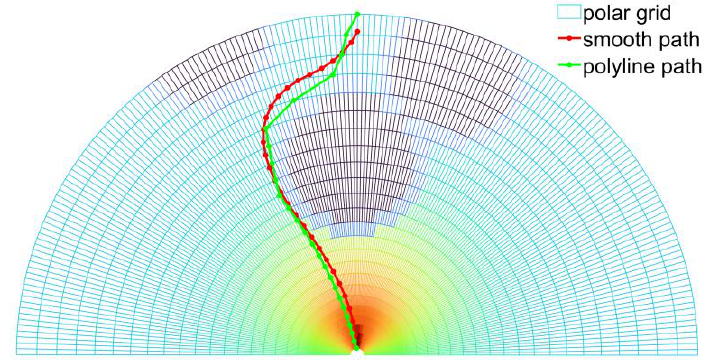
Figure 12. Illustration of the generated smooth, collision-free paths.